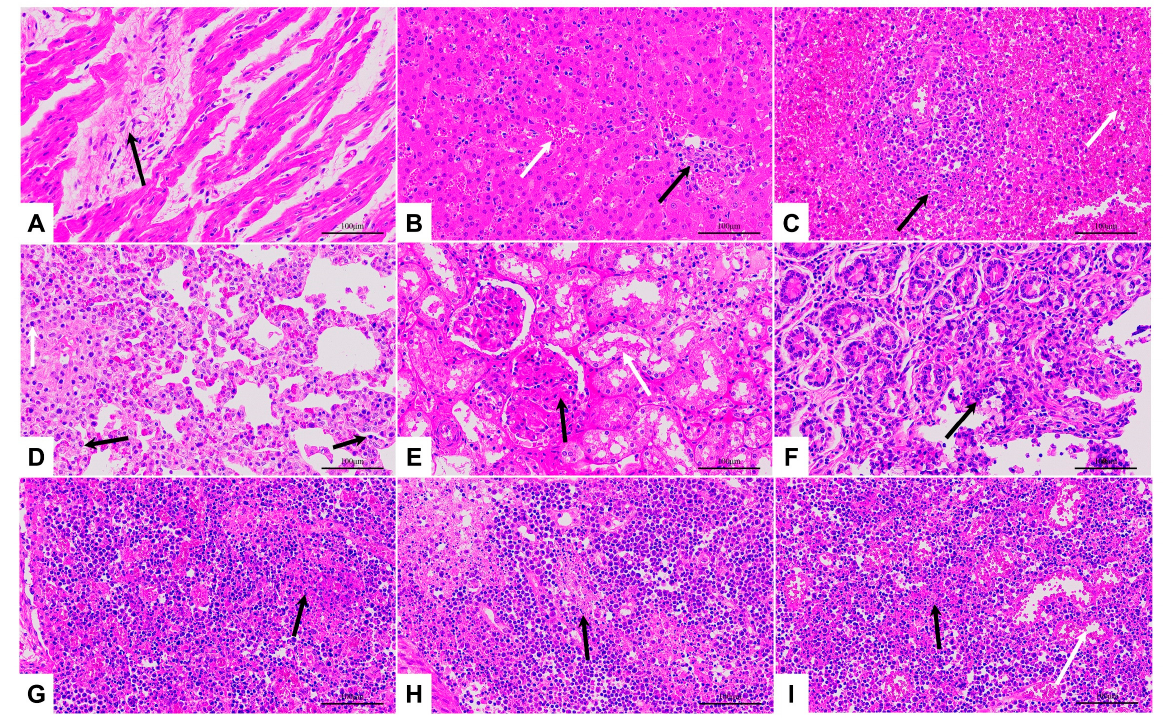
Figure 5. Histopathological section (H and E staining, 400 × ) ( A ) Heart from pig No. IM200-2, fibrous tissue hyperplasia visible in areas (black arrow) of the myocardial interstitium; ( B ) Liver from pig No. IN40-2, congested and enlarged hepatic sinusoids (white arrows) with inflammatory cell infiltration (black arrows); ( C ) Spleen from pig No. IO200-2, atrophy of splenic nodules, massive cell necrosis, broken nuclei (black arrows), and reduced lymphocytes (white arrows); ( D ) Lung from pig No. IO40-3, partial alveolar atrophy with inflammatory cell infiltration (black arrow) and cells with fragmented nuclei (black arrow); ( E ) A kidney from pig No. IO100-2, tubular epithelial cells with oedema, loose vacuolation of the cytoplasm and dilated lumen (white arrow), glomerular amyloidosis, thickened basement membrane, and poorly defined capillary collaterals (black arrow); ( F ) Intestine from pig No. IM200-1, epithelial cells of the mucosal layer are eroded and detached, the lamina propria is exposed, and limited infiltration of inflammatory cells is visible (black arrow); ( G ) Thymus from pig No. IO200-3, necrotic degeneration of cells with fragmented nuclei (black arrow); ( H ) Inguinal lymph node from pig No. IO1000-2, with necrotic degeneration of lymphocytes, and fragmentation of nuclei (black arrow); ( I ) Submandibular lymph node from pig No. IO200-3, necrotic degeneration of lymphocytes with fragmented nuclei (black arrow), and extensive vasodilation and congestion (white